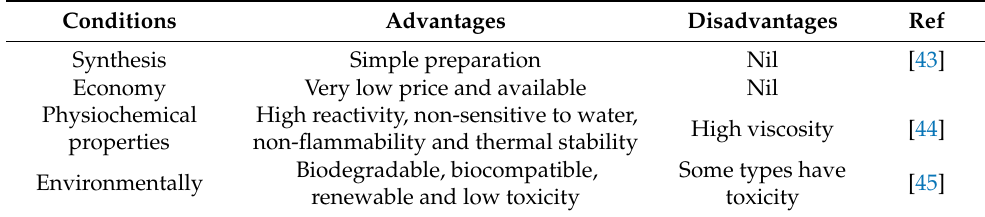
Table 1. Main advantages and disadvantages of